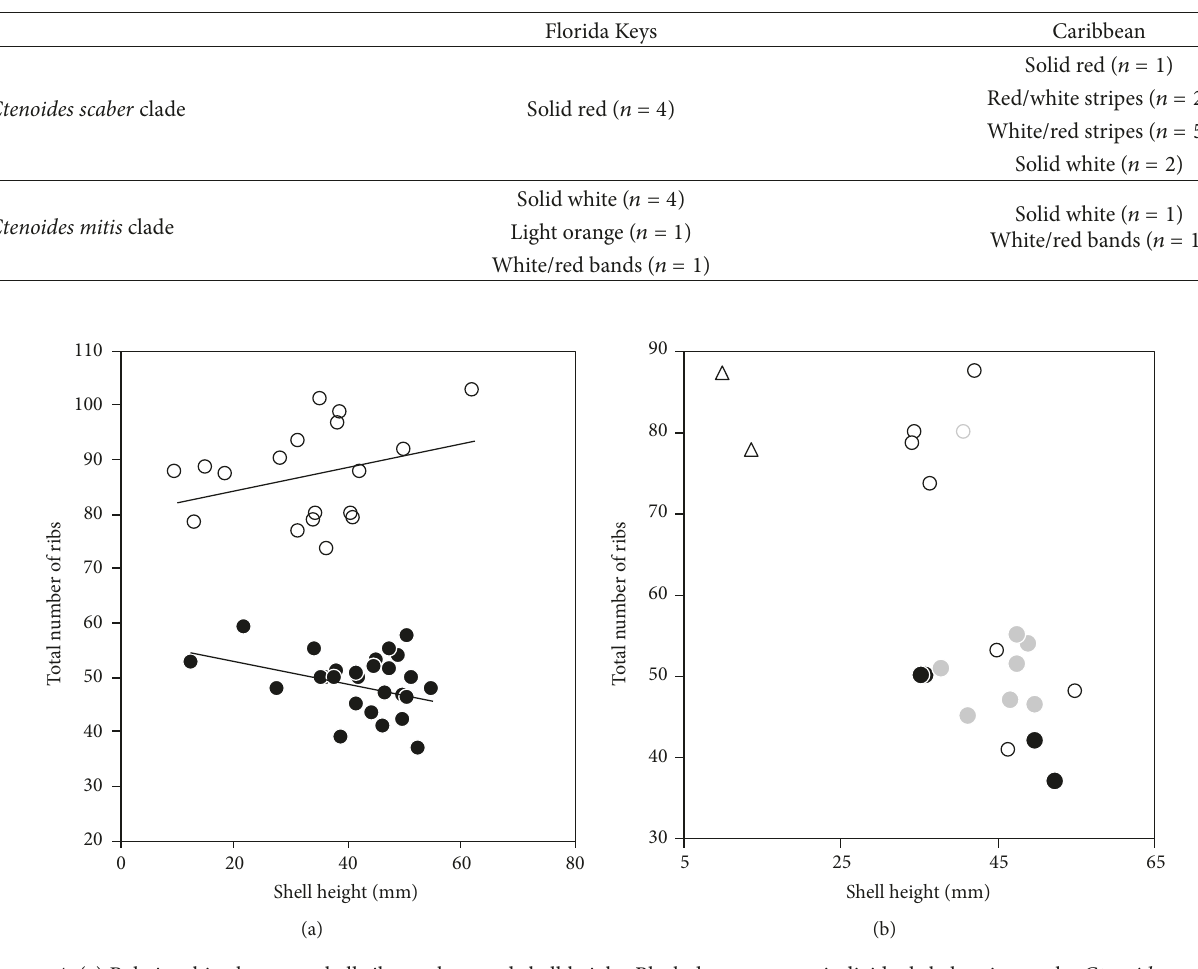
Table 2: Tentacle color patterns based on locality and phylogenetic position.